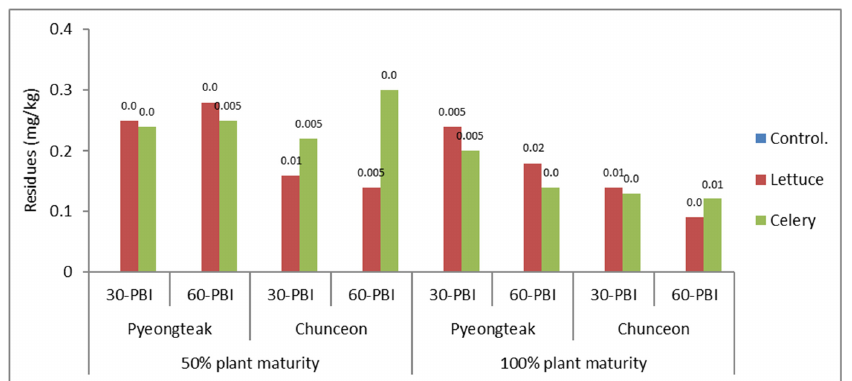
Figure 3. Dinotefuran residues (mg/kg) remaining in the soil at 50% and 100% plant maturity. Figure legend: values above the columns—standard error; PBI-30—30-day plant back intervals; PBI-60—60-day plant back intervals. Sample size: 4 samples. Table 2. Dinotefuran total a) residues (mg/kg *) remaining in soils samples of ( A ) lettuce and ( B ) celery.